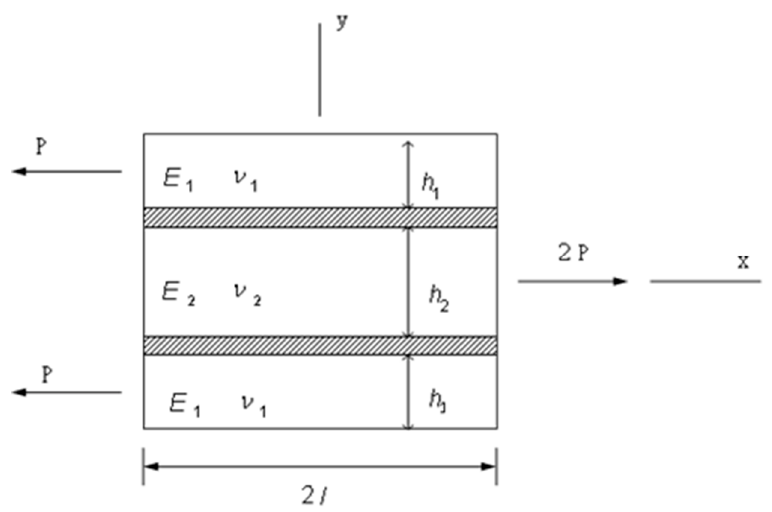
Figure 2. Geometric model in the overlap region.